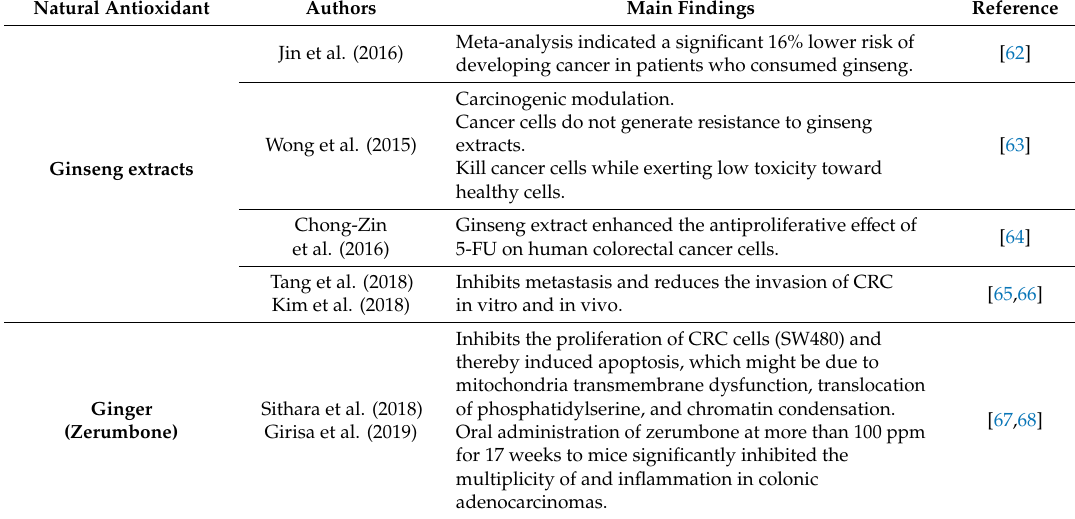
Table 2. Natural antioxidants for the prevention and treatment of colorectal cancer; recent reports from 2015 to